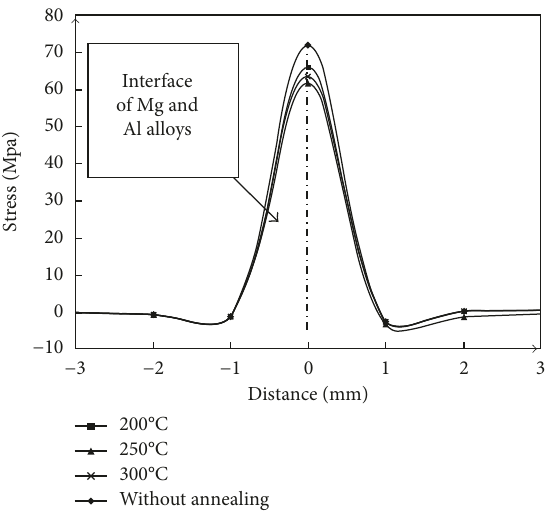
Figure 5: Residual stress of specimens annealed at different